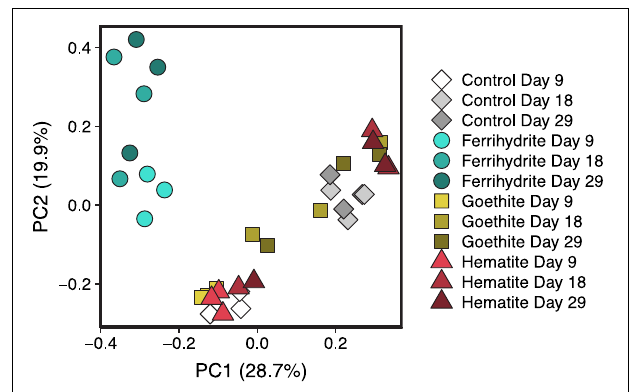
FIGURE 4 | PCoA plot of microbial communities based on ASV relative abundance data. Each time point for each experimental condition has 3 replicates represented